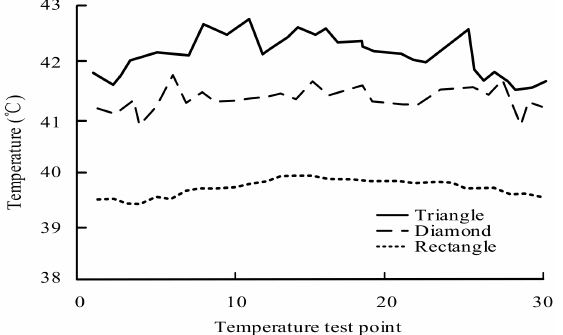
Figure 10. Numerical simulation on three different shapes of battery